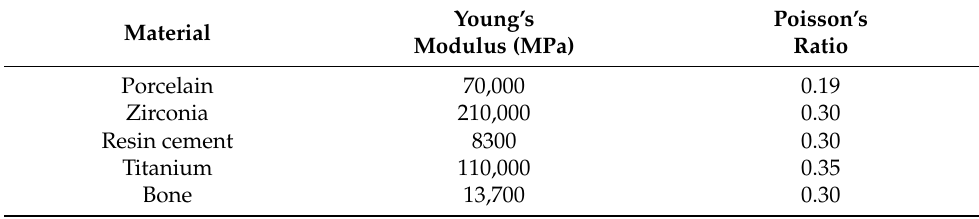
Table 1. Material properties attributed to various components in the